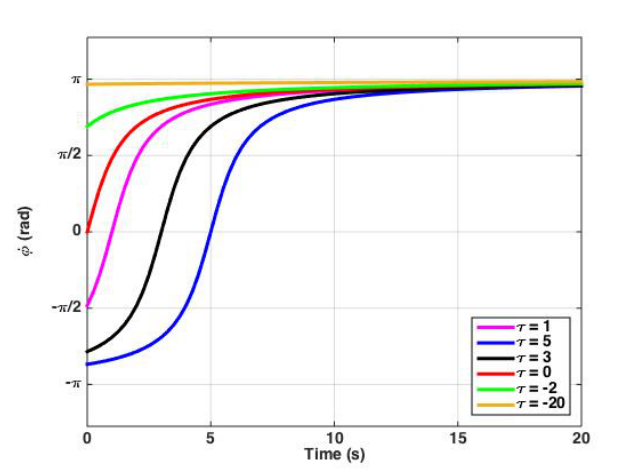
Figure 4. The evolution of relative phase when ω 1 = ω 2 . The relative phase ( φ ) as a function of time for different initial conditions when C = 0.02. This is a special case when the relative frequency of the oscillators ω is zero, which means they oscillate with the same frequency. One can see that they become phase-locked as time increases. In this special case, since ω = 0, the fixed relative phase will be π